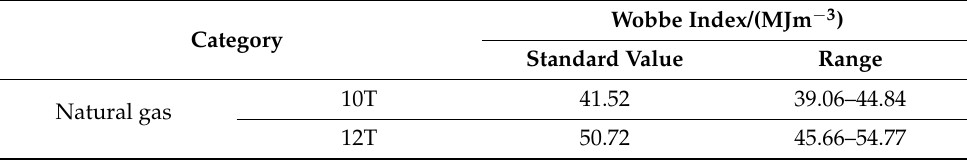
Table 3. Characteristic index of different classes of urban natural gas (at 15 ◦ C and 101.325